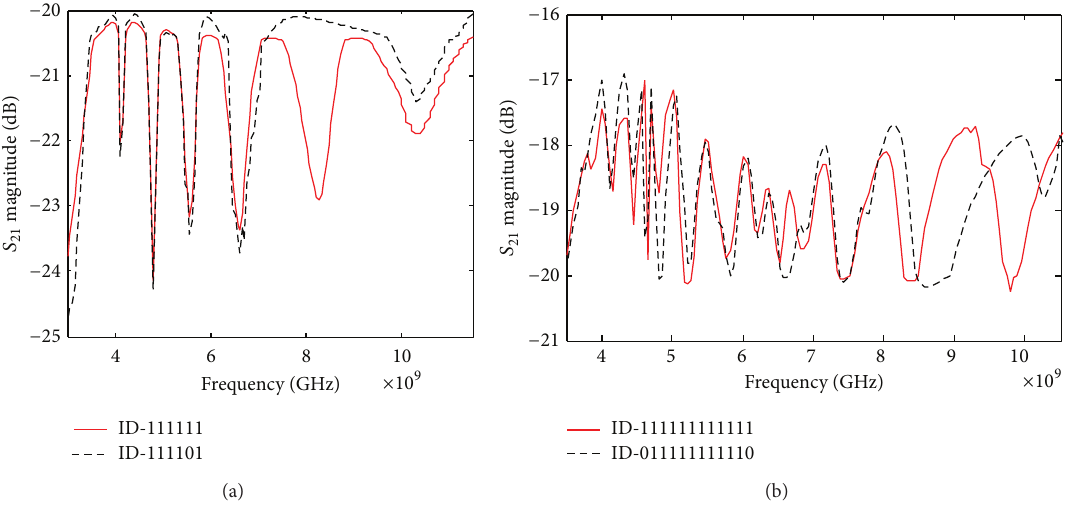
Figure 9: (a) The measurement results of tag I and tag II. (b) The measurement results of tag III and tag